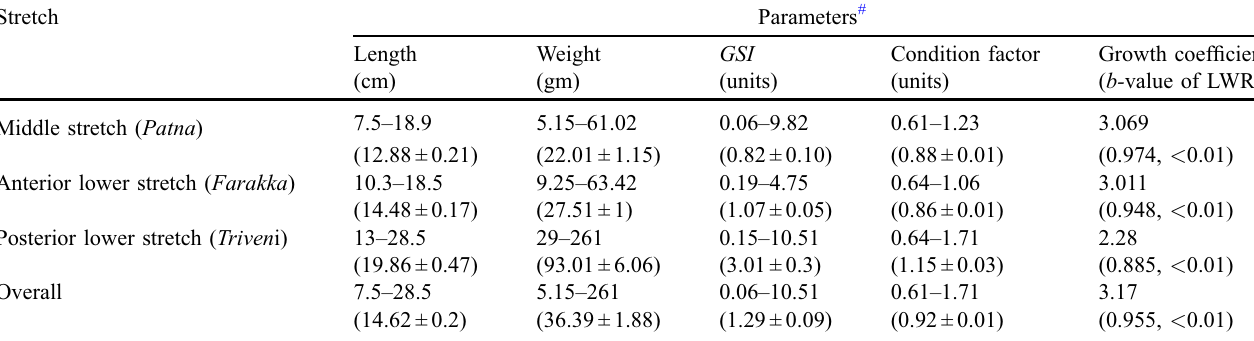
Table 1. Details of female J. coitor sampled from selected stretches of river Ganga.